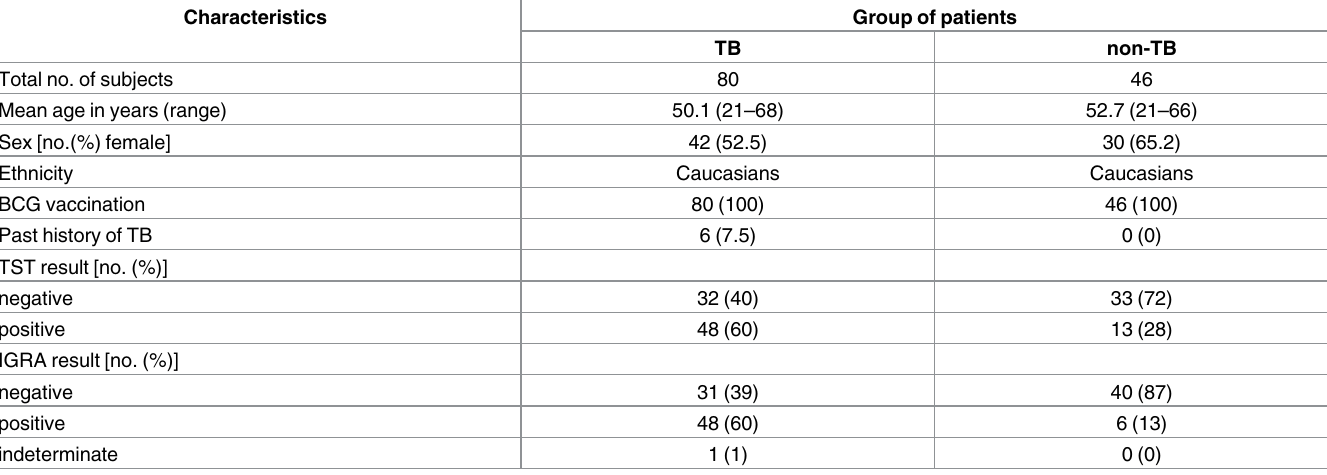
After the collection of blood for DNA extraction and IGRA testing, all individuals were screened with 2 tuberculin units (TU) of M . tb PPD RT-23 (Statens Serum Institute, Copenha- gen, Denmark), injected intradermally in the forearms by trained medical staff as described previously [7, 8]. The reaction was considered positive if the diameter of skin induration mea- sured 72 hours after PPD administration was equal or greater than 10 mm. Table 2. Characteristics of the groups of lung disease patients under